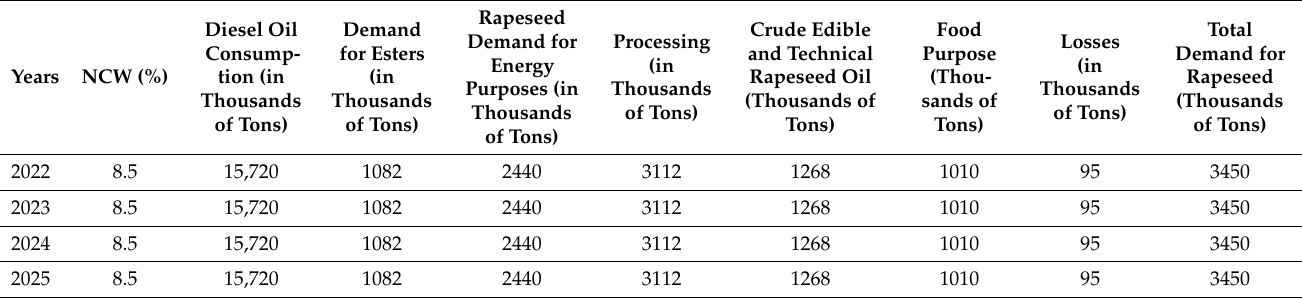
Table 3. Assumptions for the scenario of no change in the demand for rape.